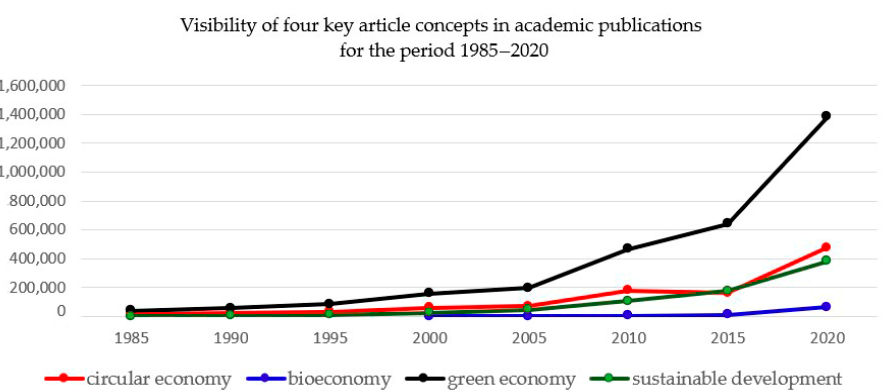
Figure 2. The bibliographic visibility of the concepts in the models of the new economy, compared to the concept of sustainable development. Legend: the x -axis is the years; the y -axis is the number of references to the four above-listed concepts; the graphs for the three models of the economy are scaled 10:1. Source: compiled by the authors based on the data from the following web platform: https://app.dimensions.ai/discover/publication (accessed on 25 November 2020).